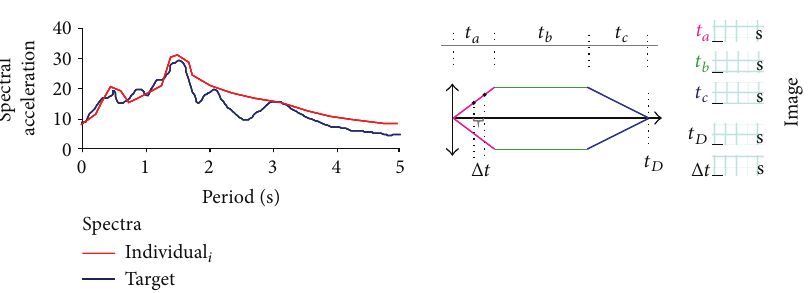
Figure 17: Genetic generation: modifications on line